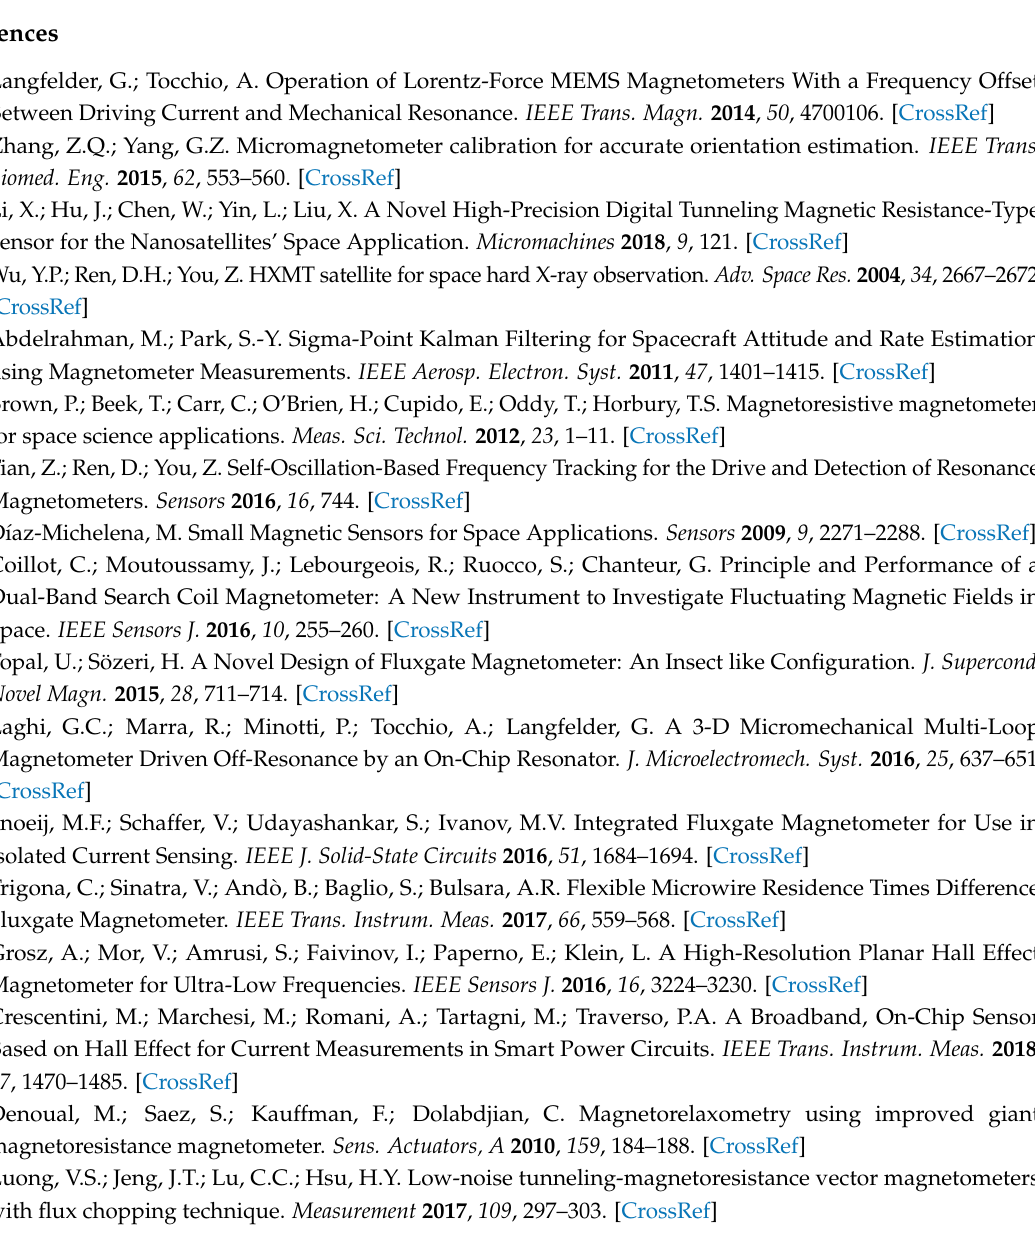
Figure S1: The layout of the double coil. (a) The upper coil of the double coil system, and (b) the sublayer of the double coil, connecting the upper layer coil in the center, Figure S2: Circuit principle of the magnetometer, Figure S3: Sketch map of the torsional structure, Table S1: Torsional beam parameters, Table S2: Comparisons of different prototypes, Table S3: Measured and calculated coil resistances of different magnetometer